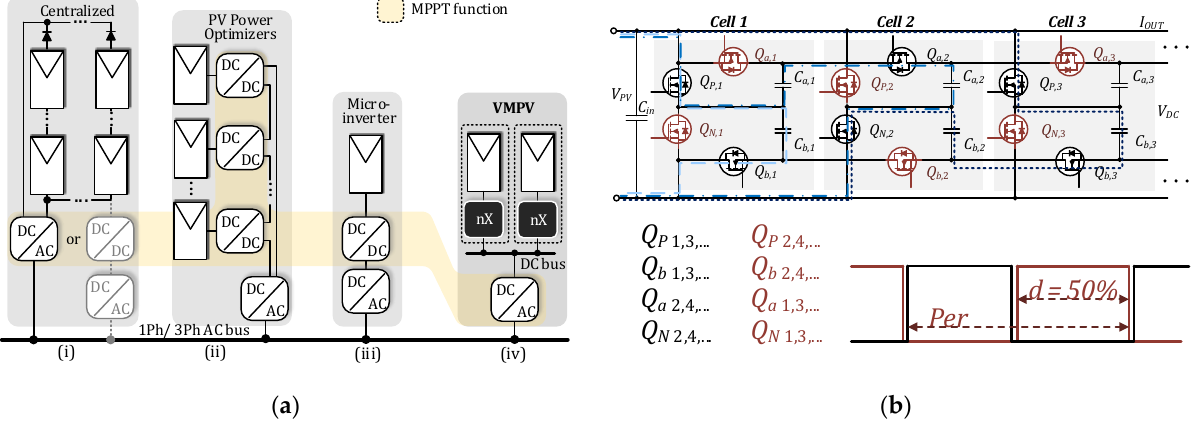
Figure 1. ( a ) PV architectures, including ( i ) central inverter, ( ii ) PVPOs ( iii ) micro-inverters and ( iv ) the proposed VMPV architecture. ( b ) Schematic diagram of the magnetic-free SC voltage amplifier.